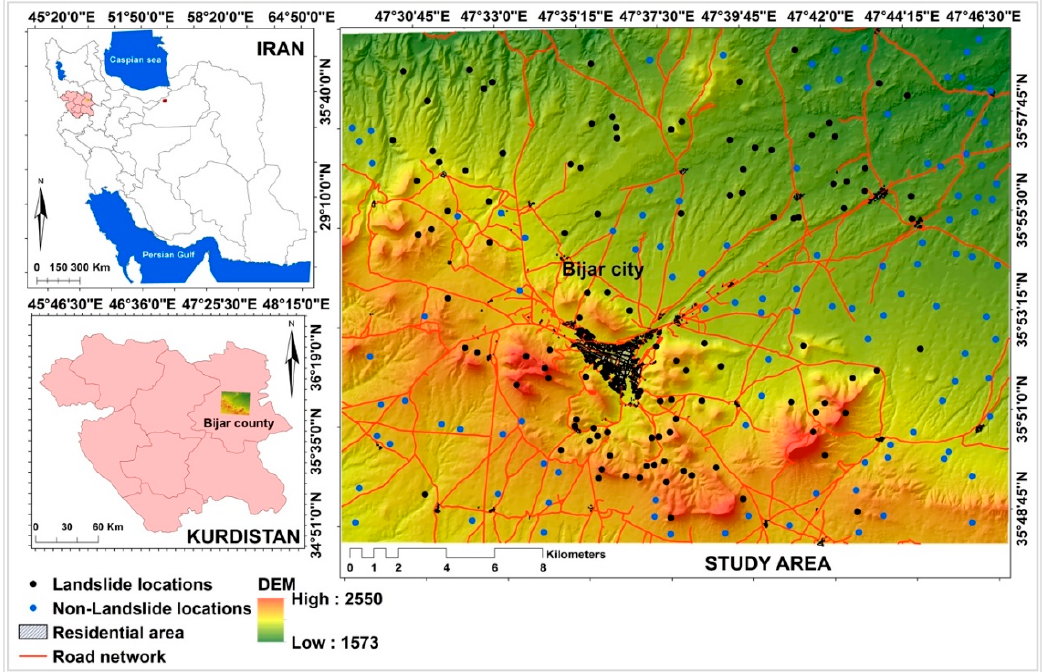
Figure 1. Location of landslides in the study area in Kurdistan Province of Iran.